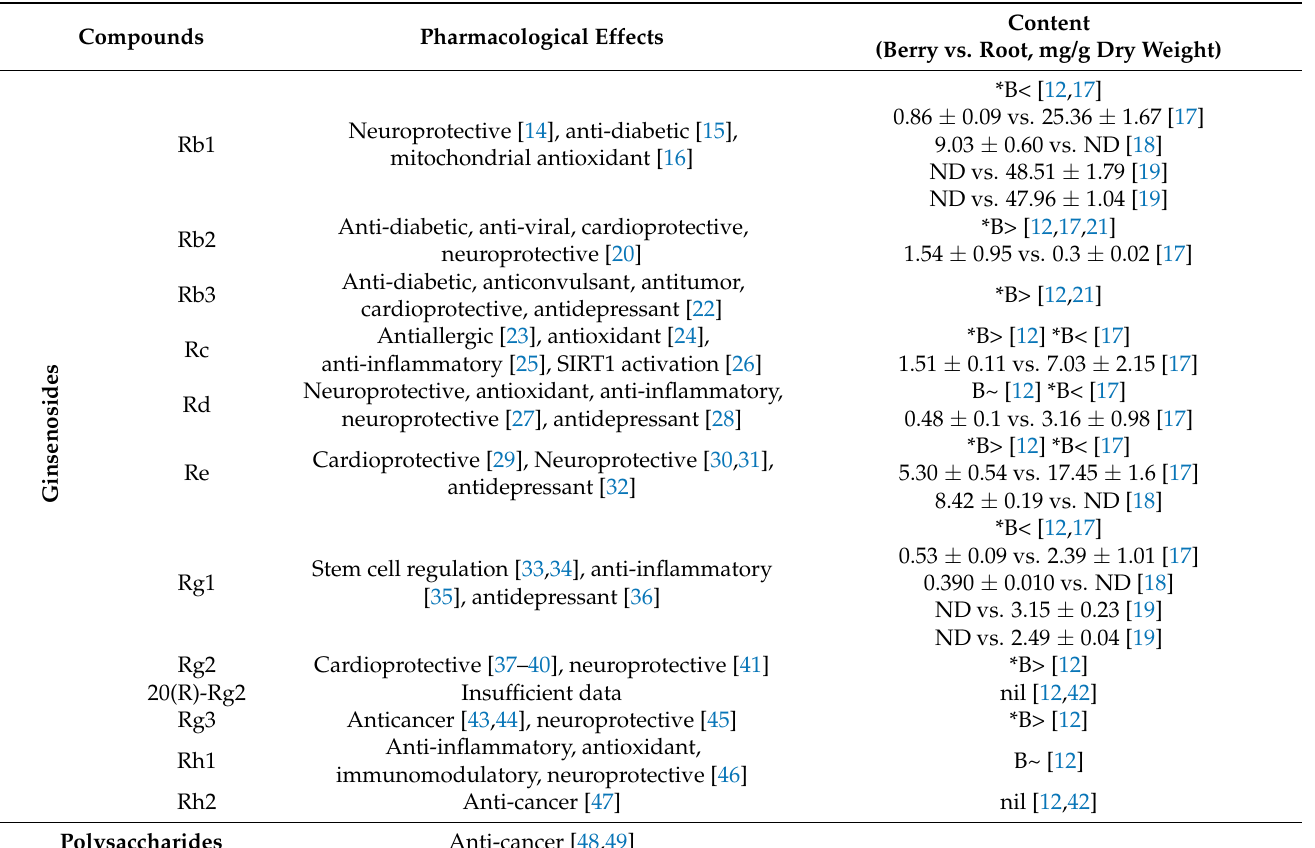
Table 1. A review of American ginseng berry bioactive compounds—(*B>) content is significantly higher in the berry than root, (*B<) content is significantly less than the root, (B~) content is not statistically different from the root, (nil) was not detected in the berry, (ND) not determined in the study. Significance was determined using a two-tailed t -test with p < 0.05. When multiple harvest times were available in a study, the harvest date closest to August 30th was